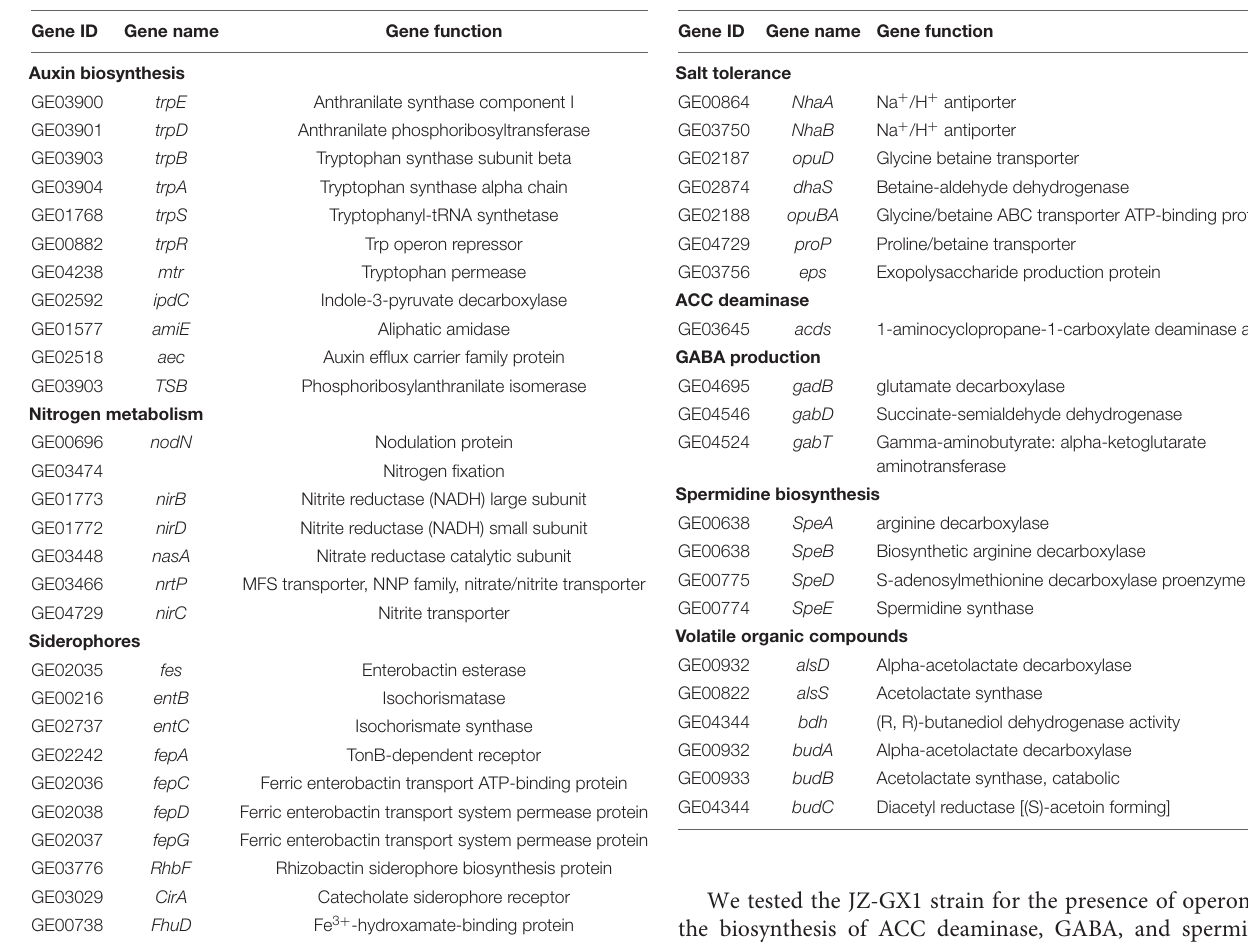
TABLE 2 | Genes related to plant growth-promoting activities in the Rahnella victoriana JZ-GX1 genome.